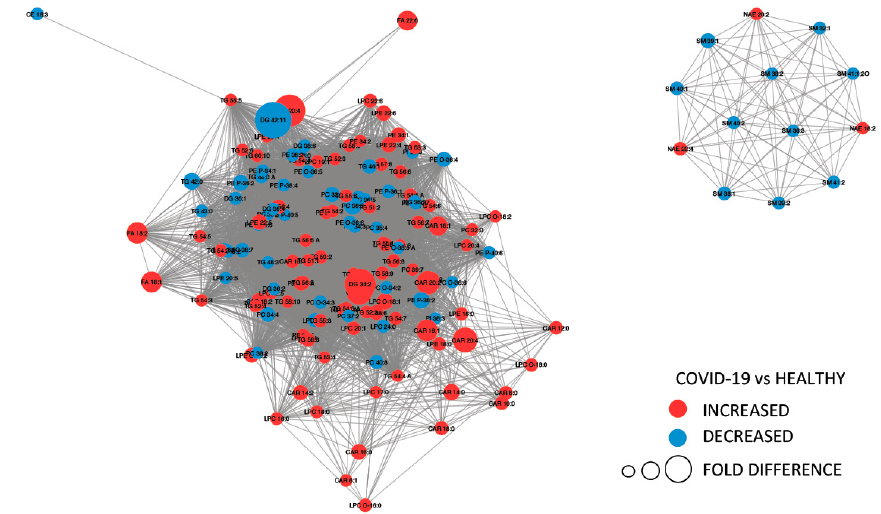
Figure 4. MetaMapp visualization of lipidomic changes in COVID-19 patients. Lipids with increased concentration are depicted using red nodes, while lipids with decreased concentration are represented by blue nodes. The lipids grouped on the right are sphingomyelins and N -acyl ethanolamine, while on the left are reported glycerolipids.